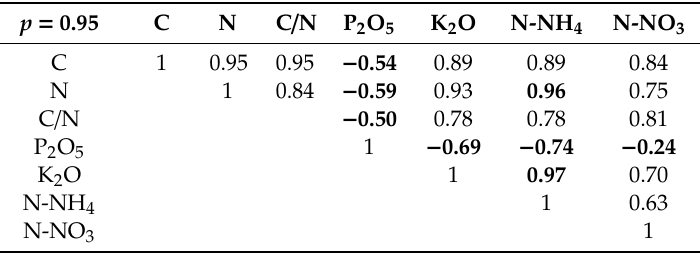
Table 6. Spearmen’s correlation of the studied